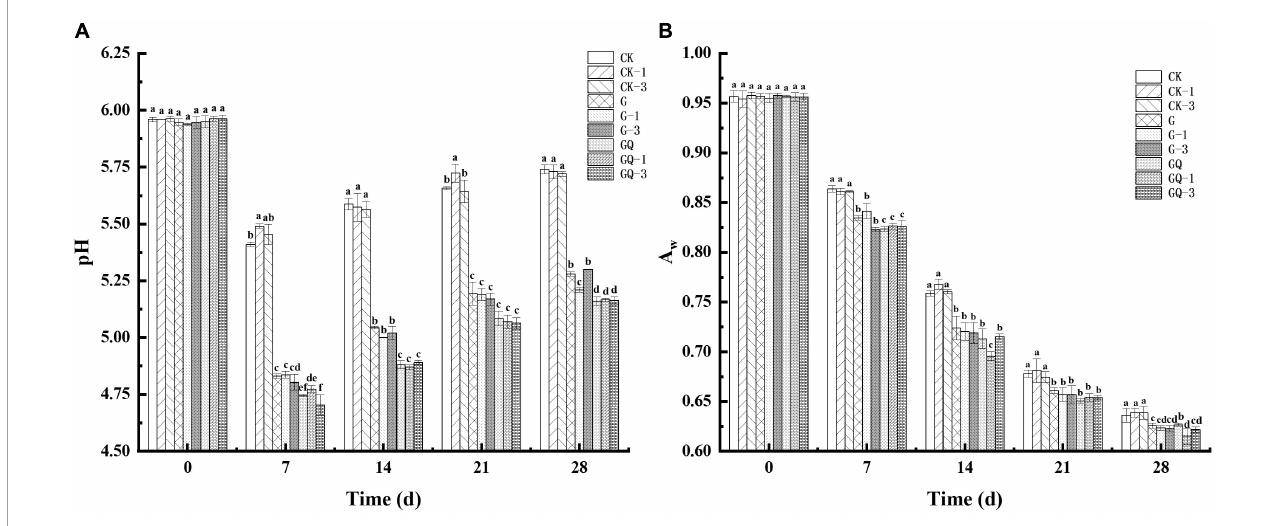
FIGURE1 The pH values (A) and a w (B) of fermented sausages among treatments during the fermentation for 0, 7, 14, 24, and 28 days. Different lowercase letters (a–f) indicate a significant difference between different treatment groups at the same fermentation time ( P < 0.05). The group without starter culture and leucine was assigned to the CK group. The groups added with 1 and 3 mM of leucine without starter culture were assigned to the CK-1 and CK-3 groups, respectively. The group with Lactobacillus fermentum YZU-06 was assigned to the G group. The groups with Lactobacillus fermentum YZU-06 and different concentrations of leucine (1 and 3 mM) were named G-1 and G-3 groups, respectively. The fermented sausage with the mixed-starter cultures of Lactobacillus fermentum YZU-06 and Staphylococcus saprophyticus CGMCC 3475 was assigned to the GQ group. The groups with the mixed-starter cultures and different concentrations of leucine (1 and 3 mM) were named GQ-1 and GQ-3 groups, respectively.